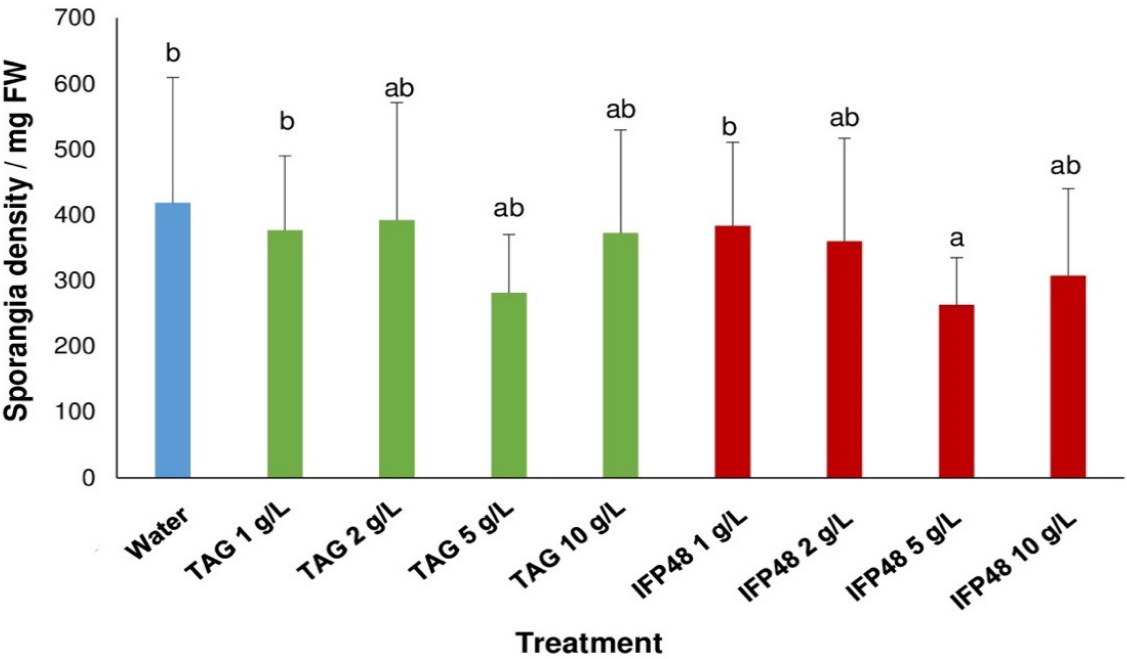
Figure 2. Downy mildew disease severity in grapevine leaves after root treatment with D-tagatose and its formulated product IFP48. Roots of in vitro-grown grapevine plantlets were treated with 1, 2, 5, and 10 g/L D-tagatose-based formulated product (IFP48) or pure D-tagatose (TAG). As control, plants were treated with water. Leaf inoculation was carried out at three days post treatment (3 dpt) and disease severity was evaluated by counting the Plasmopara viticola sporangia at eight days post inoculation (8 dpi). Data are means ± SD from eight plants with five leaves per plant and three independent experiments that showed similar results. Different letters indicate significant differences according to the one-way ANOVA Welch’s test with Student’s t -test ( p ≤ 0.05). The aerial part treatment with IFP48 and TAG reduced sporangia density of P. viticola (Figure 3) and downy mildew severity (Supplementary Figure S2). In particular, sporangia density was comparable between IFP48 and TAG at 1, 2, and 5 g/L, whereas aerial